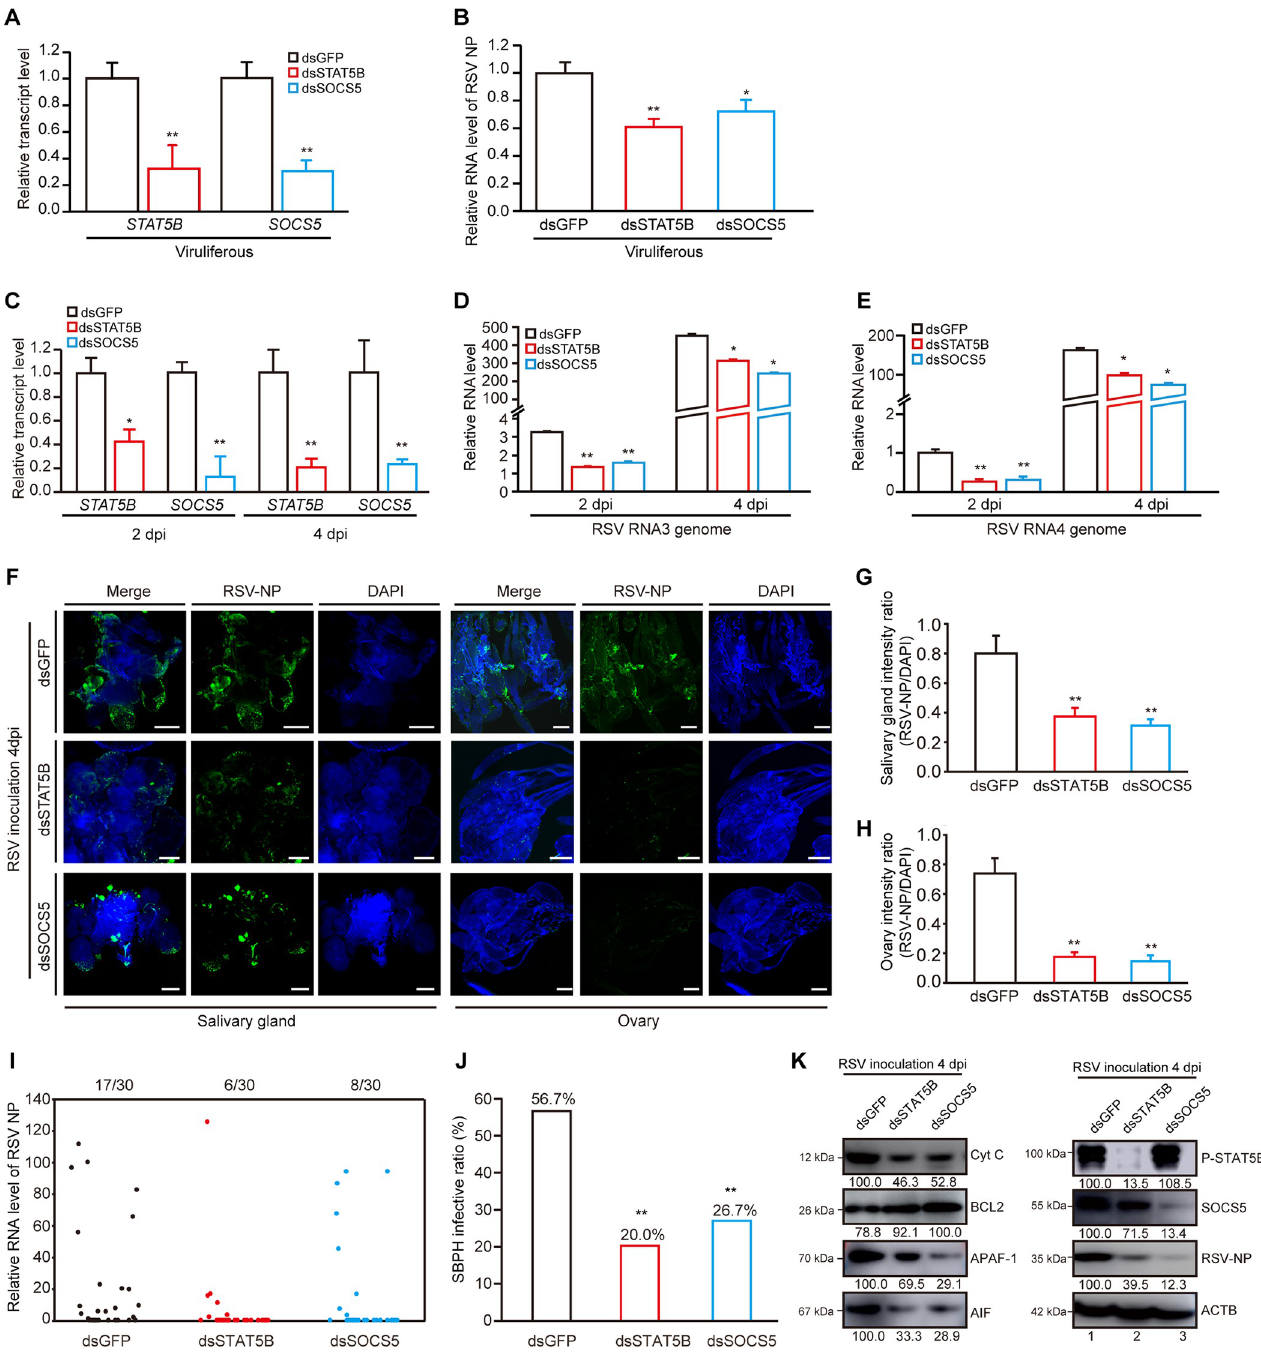
Fig 5. JAK-STAT pathway regulates apoptosis to promote viral infection. (A) Relative transcript levels of STAT5B and SOCS5 in viruliferous SBPHs after silencing STAT5B and SOCS5 for 48 h as determined by qRT-PCR. Injection of ds GFP into viruliferous SBPHs was acted as the control group. (B) Quantitative RT-PCR analysis of RSV NP in viruliferous SBPHs after silencing GFP , STAT5B and SOCS5 . (C) Quantitative RT-PCR analysis of STAT5B and SOCS5 in ds GFP -, ds STAT5B or ds SOCS5 -treated SBPHs at 2 and 4 days after injection of RSV crude extracts. (D-E) Quantitative RT-PCR analysis of viral genome RNA3 (D) and RNA4 (E) in ds GFP -, ds STAT5B or ds SOCS5 -treated SBPHs at 2 and 4 days after injection of RSV crude extracts. (F) Immunolabeling detection of RSV NP (green) in salivary glands and ovaries of ds GFP -, ds STAT5B or ds SOCS5 -treated SBPHs at 4 days after injecting RSV crude extracts. Nuclei were stained with DAPI (blue). Bar, 100 μ m. (G-H) Fluorescence density of RSV NP signal in salivary glands (G) and ovaries (H). Relative intensity was quantified by ImageJ software. The experiment was replicated three times. (I) Quantitative RT-PCR analysis of RSV NP in each SBPH. The number of RSV-infected SBPHs relative to total SBPHs is shown at the top of column. Each dot represents a SBPH sample. (J) Differences in SBPH infective ratios were compared at 4